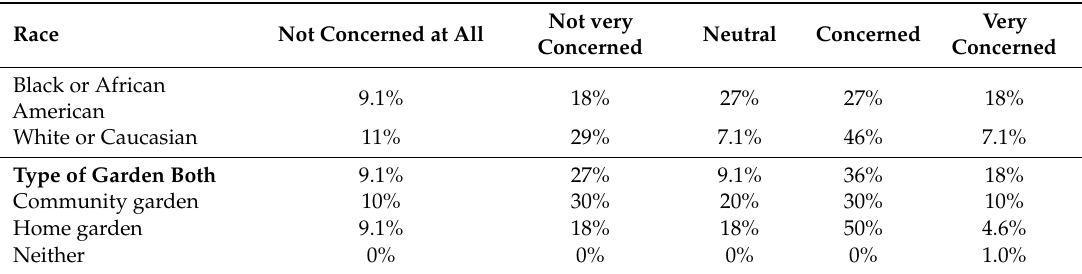
Table 1. Concern of participants with potential health e ff ects of HMM contaminants in soil by race (top) and by types of gardens (bottom).